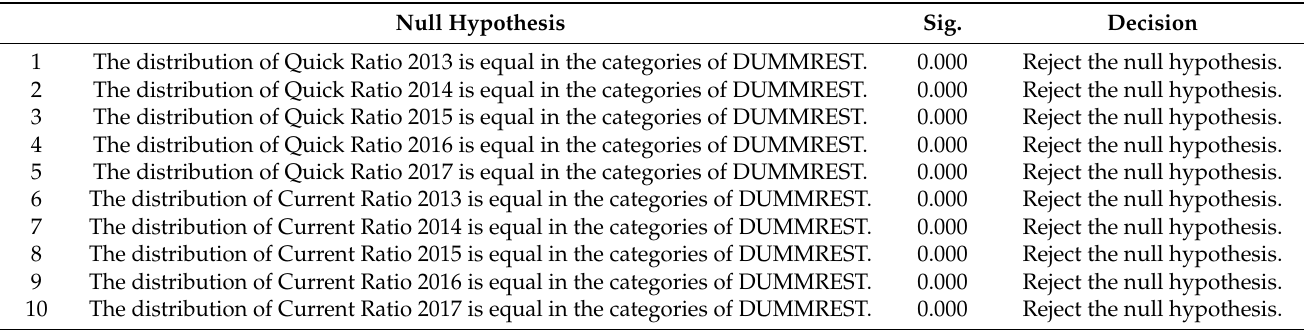
Table 10. Results of non-parametric Mann–Whitney U test.